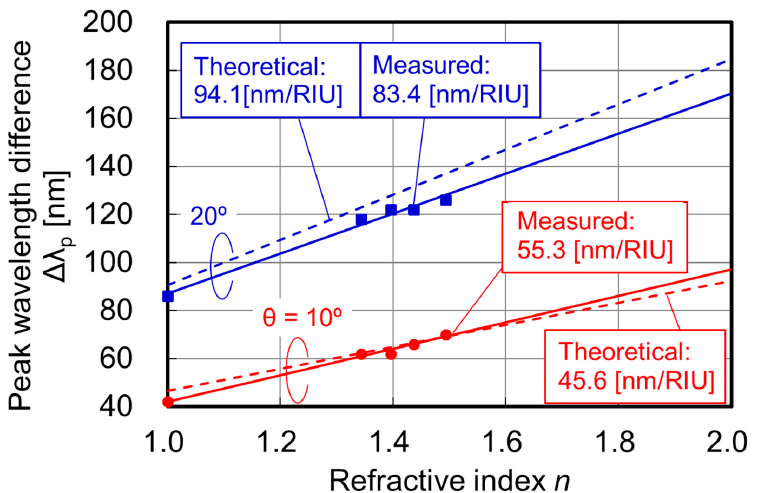
Figure 6. Peak wavelength difference in Figure 5 as a function of refractive index n with various incident angles θ . Theoretical characteristics based on Equations (2) and (3) are also shown. Sensitivity for refractive index changes can be obtained via the slope. RIU is refractive index unit.